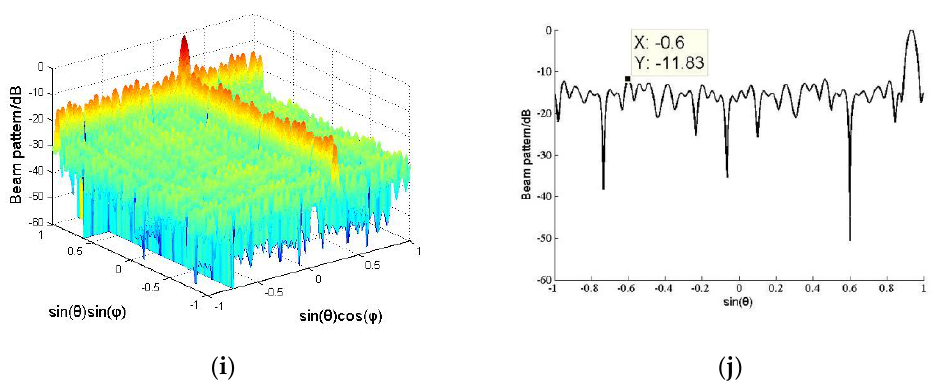
Figure 7. 3D and 2D power patterns of the obtained sparse array after ADS. ( a ) θ and ϕ are 0 ◦ ; ( b ) θ and ϕ are 0 ◦ ; ( c ) θ and ϕ are 30 ◦ ; ( d ) θ and ϕ are 30 ◦ ; ( e ) θ and ϕ are 45 ◦ ; ( f ) θ and ϕ are 45 ◦ ; ( g ) θ and ϕ are 60 ◦ ; ( h ) θ and ϕ are 60 ◦ ; ( i ) θ and ϕ are 75 ◦ ; ( j ) θ and ϕ are 75 ◦ .